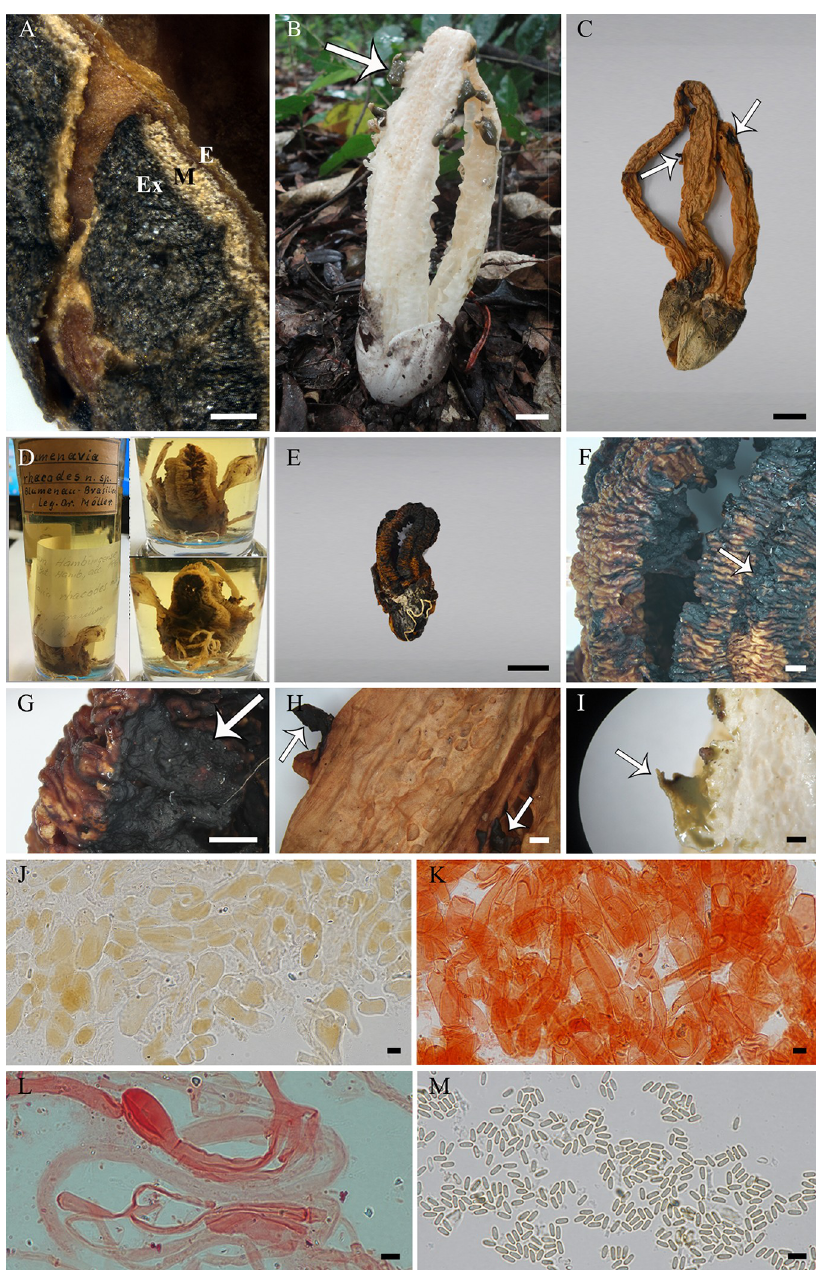
Fig 9. Blumenavia rhacodes . (A) Peridium layers, ICN177267: Ex = exoperidium, M = mesoperidium, E = endoperidium. (B–C) ICN 177266, epitype: (B) Fresh basidiomata; (C) Dry basidiomata. (D) Basidiomata preserved in alcohol, HBG 024640. (E–G) B700016478, lectotype: (E) Dry basidiomata; (F) Groove in the arm. (G) Dry glebifer. (H–K) ICN 177266, epitype. (H) Dry glebifer; (I) Fresh glebifer; (J–K) ICN 177266, epitype: (J) Apical exoperidium hyphae in 5% KOH; (K) Apical exoperidium hyphae in 1% Congo red. (L) Rhizomorph hyphae in 1% Congo red, PACA 12552. (M) Basidiospores in 5% KOH, PACA 12550. (B, C, G, H, I) Arrows indicating glebifers. (F) Arrow indicating the longitudinal outer groove. (A) bar = 0.2 mm; (B, C, E) bar = 10 mm; (F–I) bar = 1mm; (J–M) bar = 5 μ m. Photographs: (B, I) sent by Fazolino E. P.; (D) sent by Matthias Schultz.